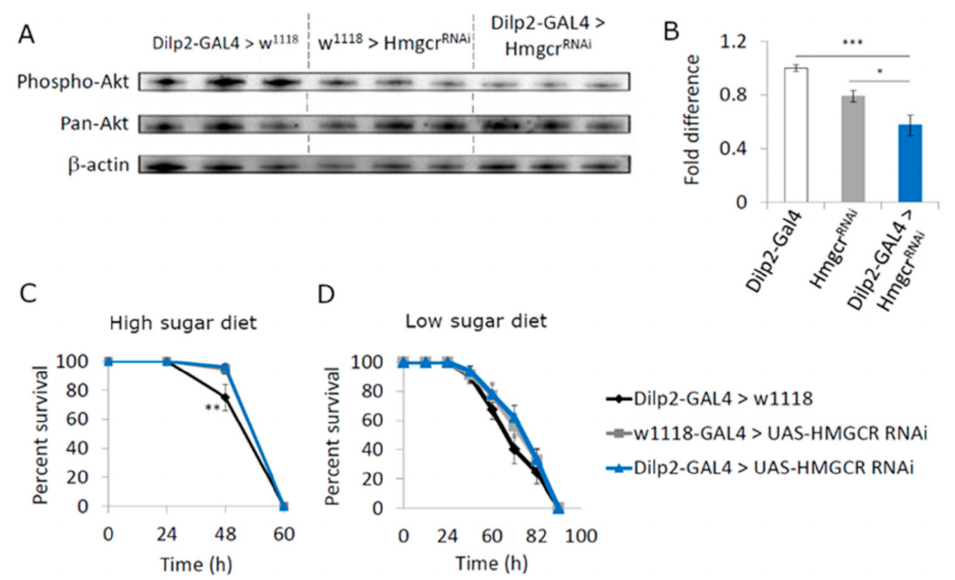
Figure 3. Hmgcr in the insulin-producing cells regulates Drosophila insulin signaling. ( A ) Western blot analysis to determine phospho-AKT levels in heads of equally aged adult males (Controls: Dilp2- GAL4 > w 1118 and w 1118 > UAS-Hmgcr RNAi ; Experimental: Dilp2-GAL4 > UAS-Hmgcr RNAi )